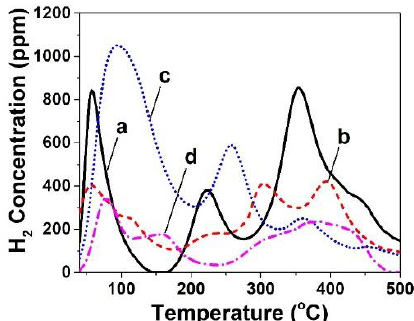
Figure 1. H 2 temperature-programmed desorption (H 2 -TPD) traces obtained over 5 wt% Ni/CeO 2-δ catalysts prepared by ( a ) Thermal Decomposition (TD), ( b ) Precipitation (PT), ( c ) Hydrothermal (HT), and ( d ) Sol Gel (SG) method; F He = 50 NmL min −1 ; β = 30 °C min −1 ; W = 0.3 g.